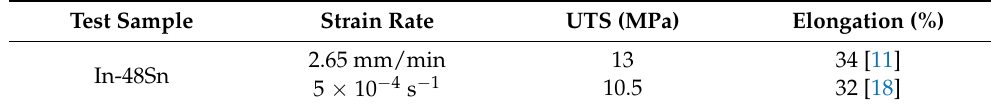
Table 3. Ultimate tensile strength and elongation of In-48Sn in previous studies. Test